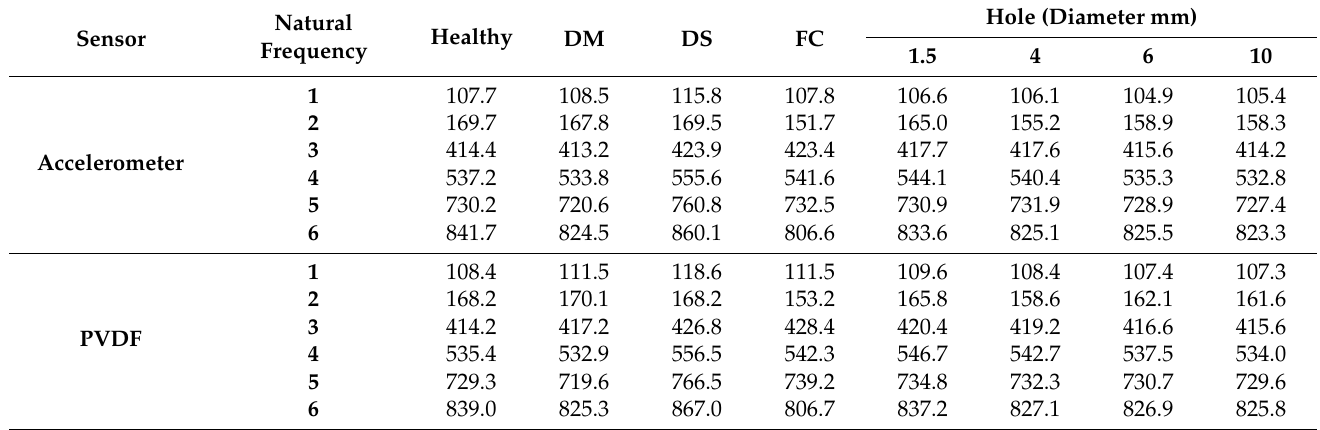
Table 2. Natural frequencies (Hz) of the 6 selected modes for the 8 plates.